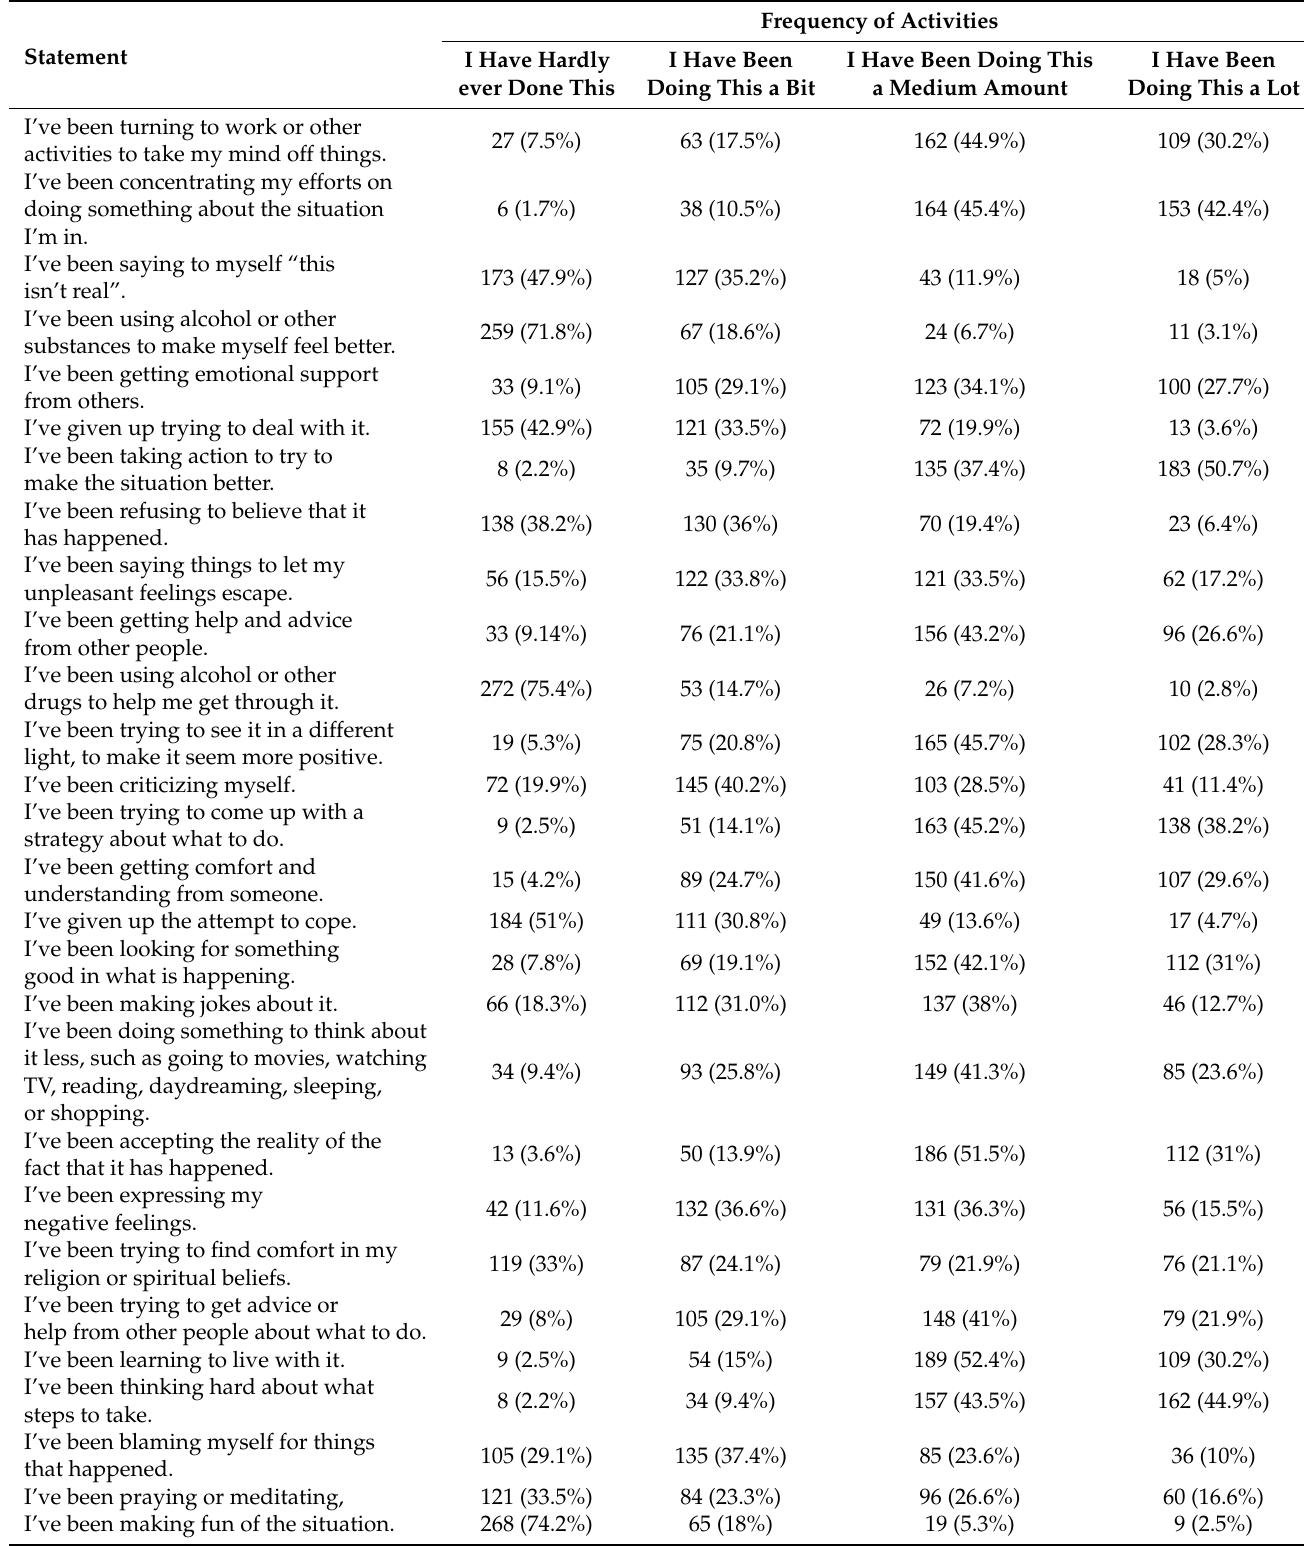
Table 3. Nurses’ responses to statements in the Brief-Cope